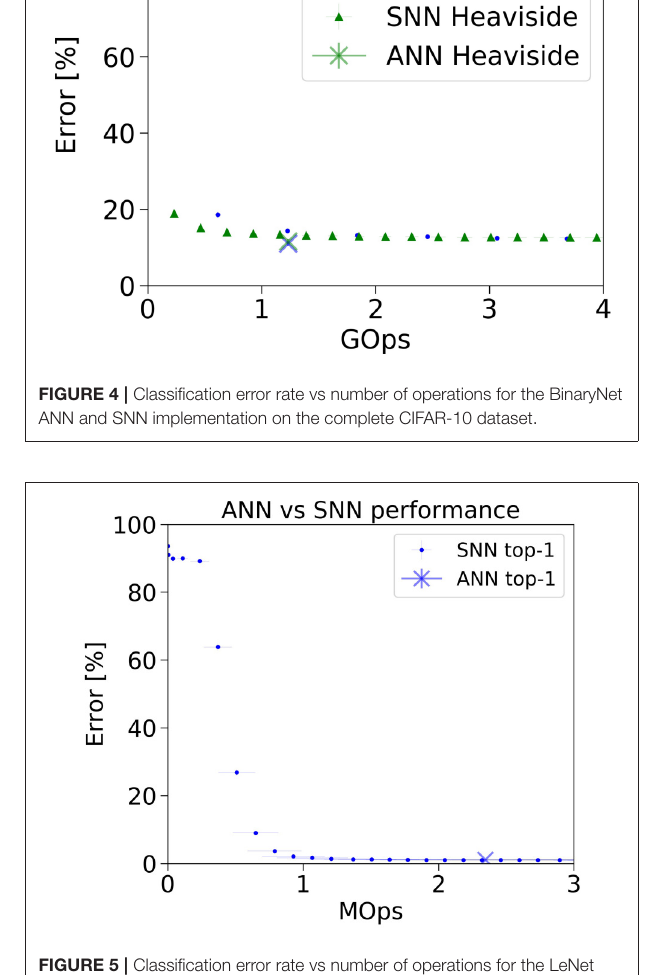
FIGURE 5 | Classification error rate vs number of operations for the LeNet ANN and SNN implementation on the MNIST